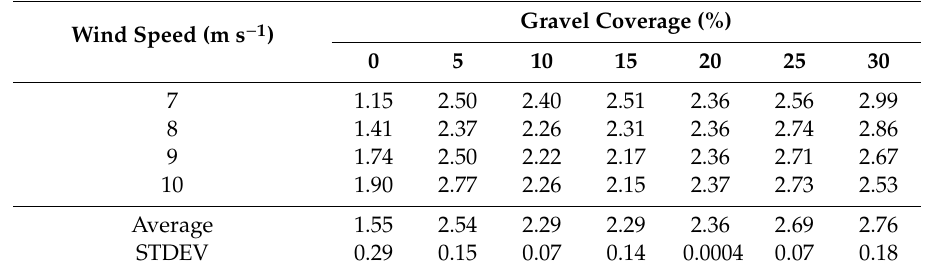
Table 1. Relationship of the Wu–Ling index ( λ ) to wind speed and gravel coverage for wind-blown sand in our